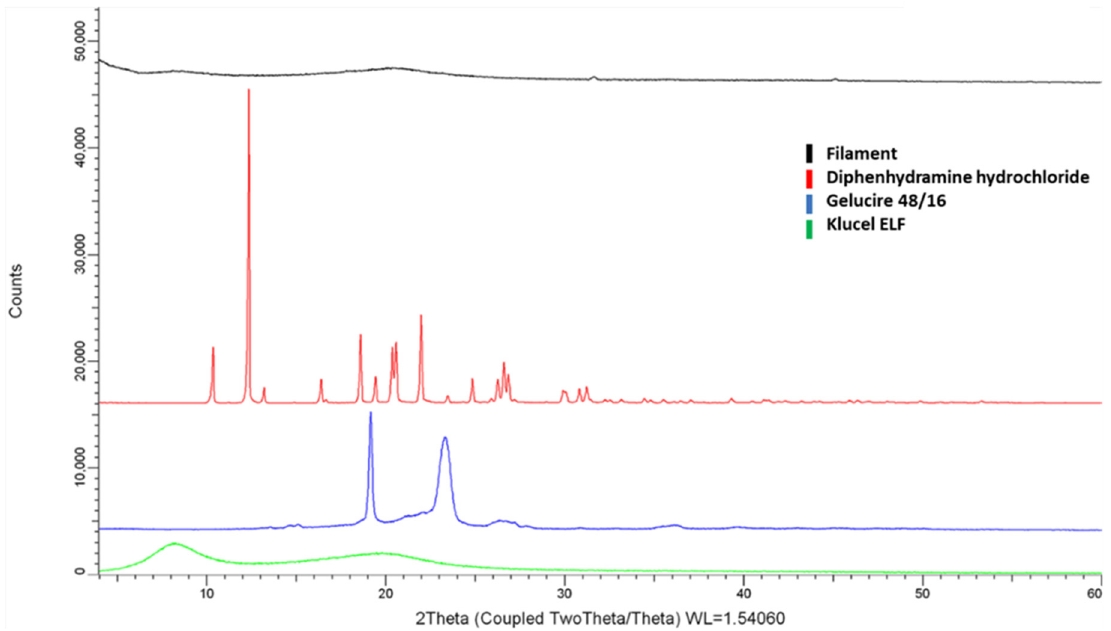
Figure 3. XRD patterns of Klucel ELF TM , Gelucire 48/16 TM , DPH and drug loaded filament.